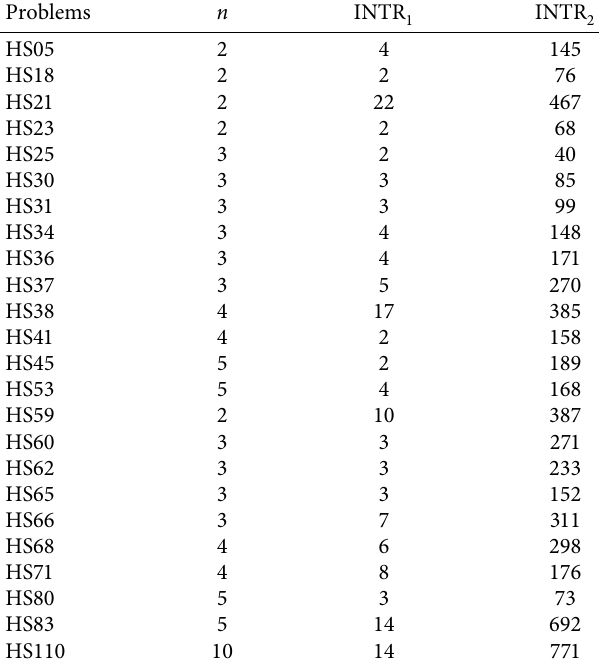
Table 2: The calculation